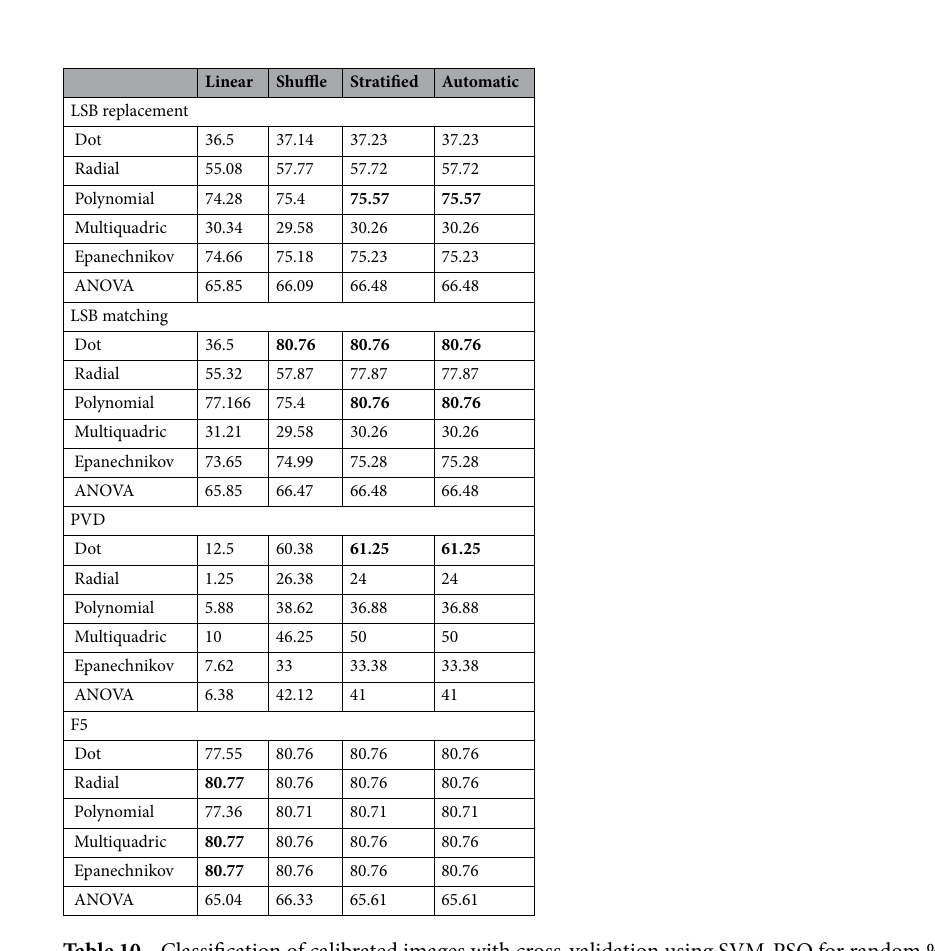
Graph 7. Result of classification of uncalibrated images with cross-validation using SVM-PSO for random %.